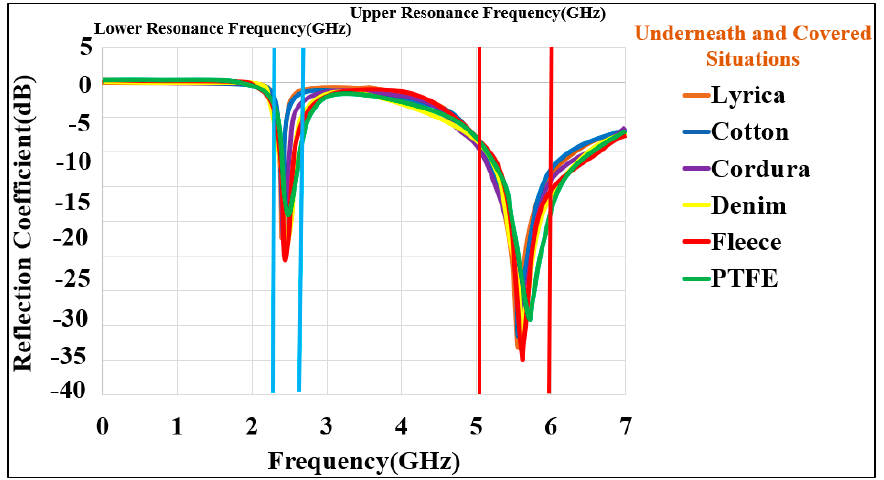
Figure 15. Reflection coefficient (S 11 ) for the proposed BSA design covering situations using various types of flexible and fabric substrate materials.